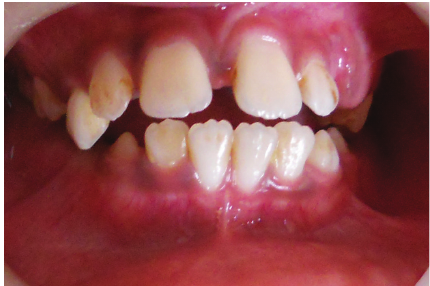
Figure 4: Showing open